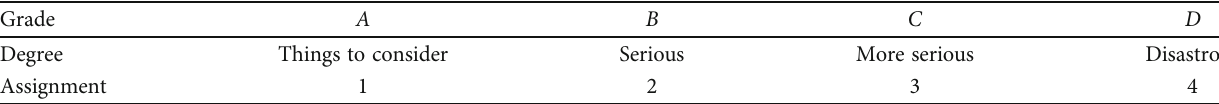
Table 2: Degree of consequence.